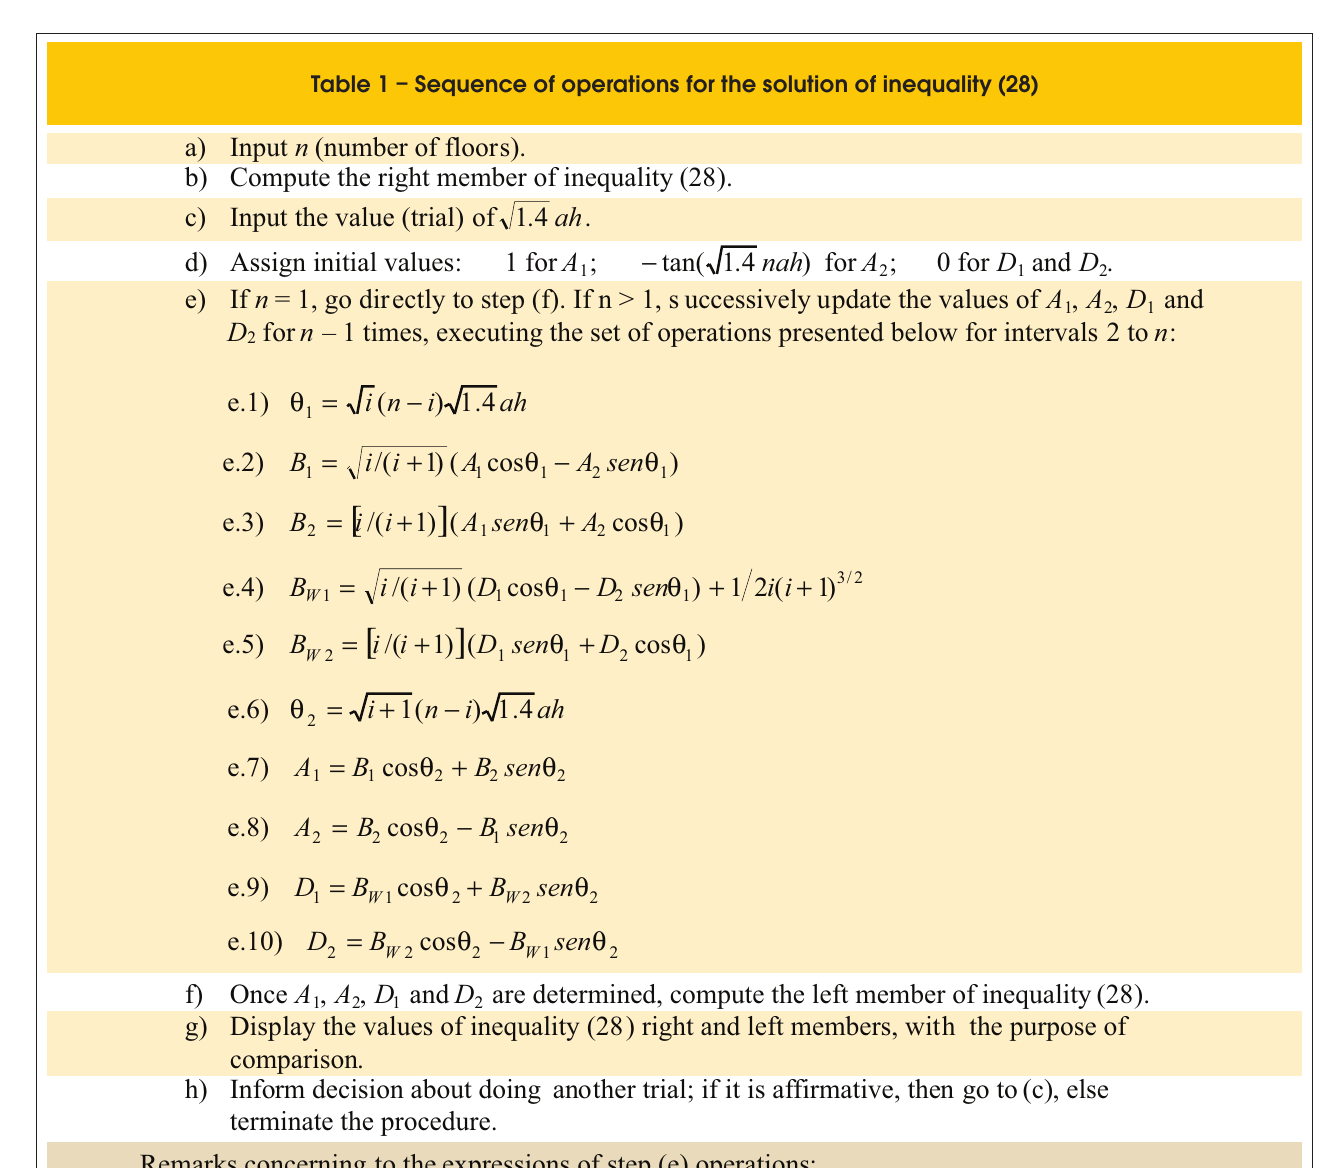
Table 1 – Sequence of operations for the solution of inequality